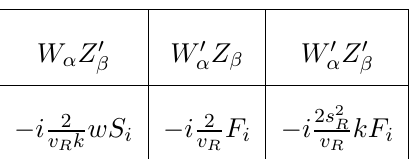
Table 14 . Same as in table 12 but for the two charged scalars H (cid:6)